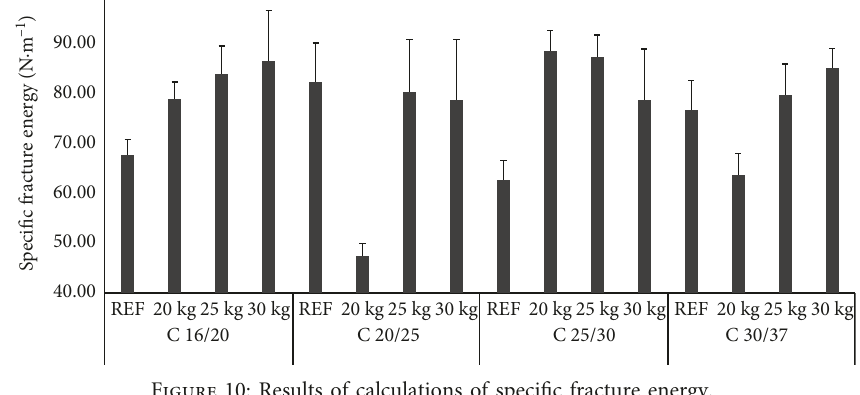
Figure 10: Results of calculations of specific fracture energy.